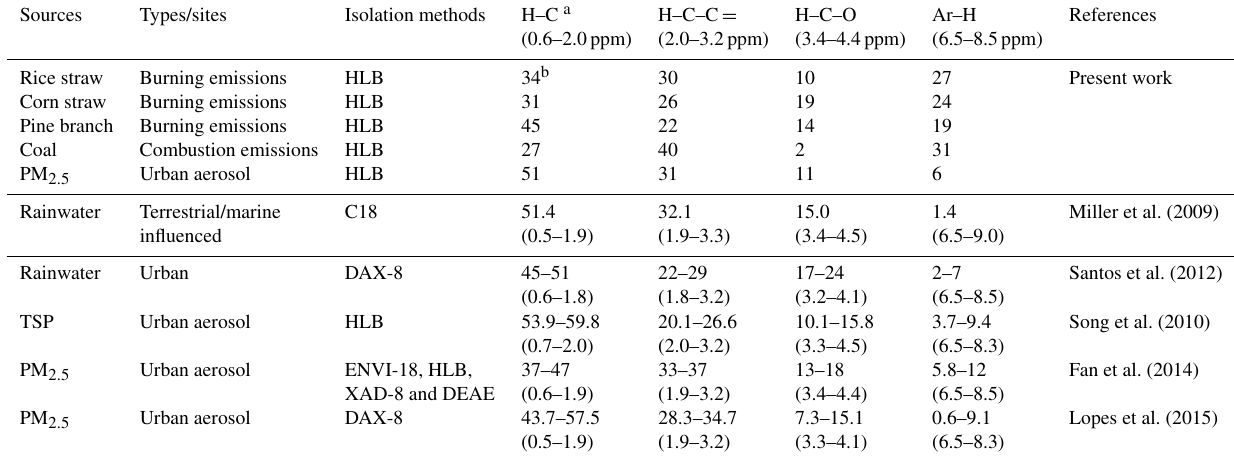
Table 6. The proton species and corresponding content percentage of HULIS in smoke PM 2 . 5 from combustion of rice straw, corn straw, pine branch, and coal, and in ambient PM 2 . 5